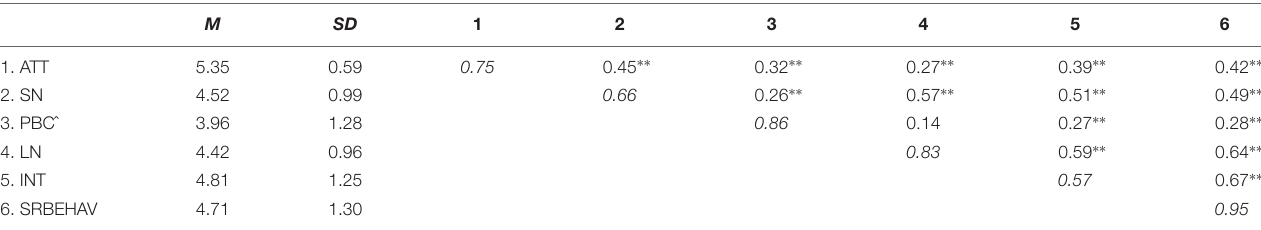
TABLE 5 | Means ( M ), standard deviations ( SD ), reliabilitycoefficients and bivariate correlations among the overall measures of attitudes (ATT), subjective norms (SN), PBC, overall local norms (LN), intentions (INT), and self-reported behavior (SRBEHAV), computed on sample 2 ( N =